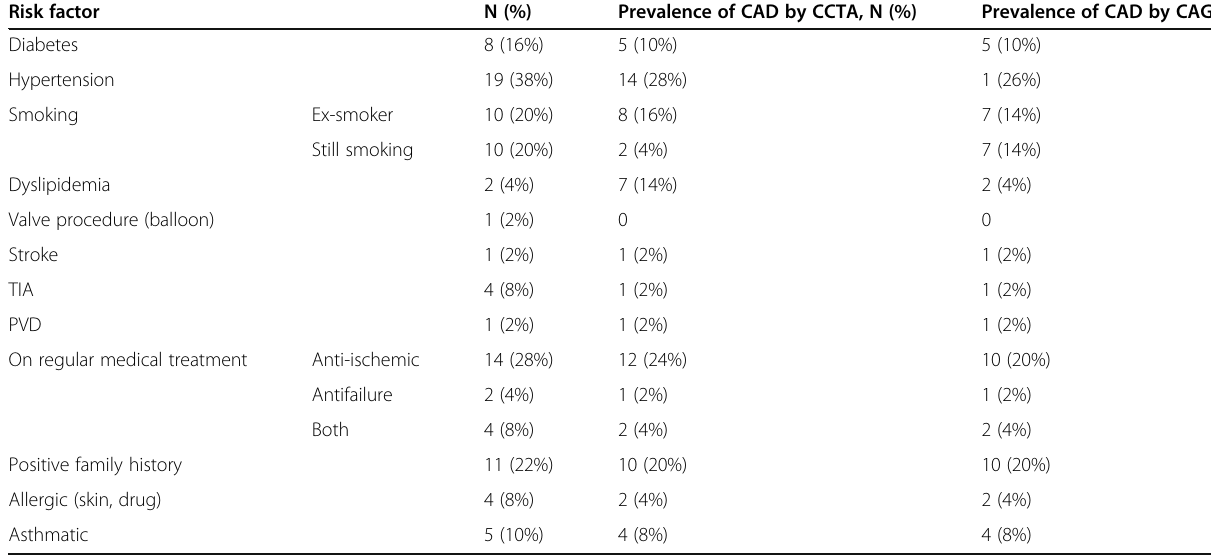
Table 1 Patient demographics: characteristics of patients with a prevalence of CAD by CCTA and CAG with each risk factor Risk factor